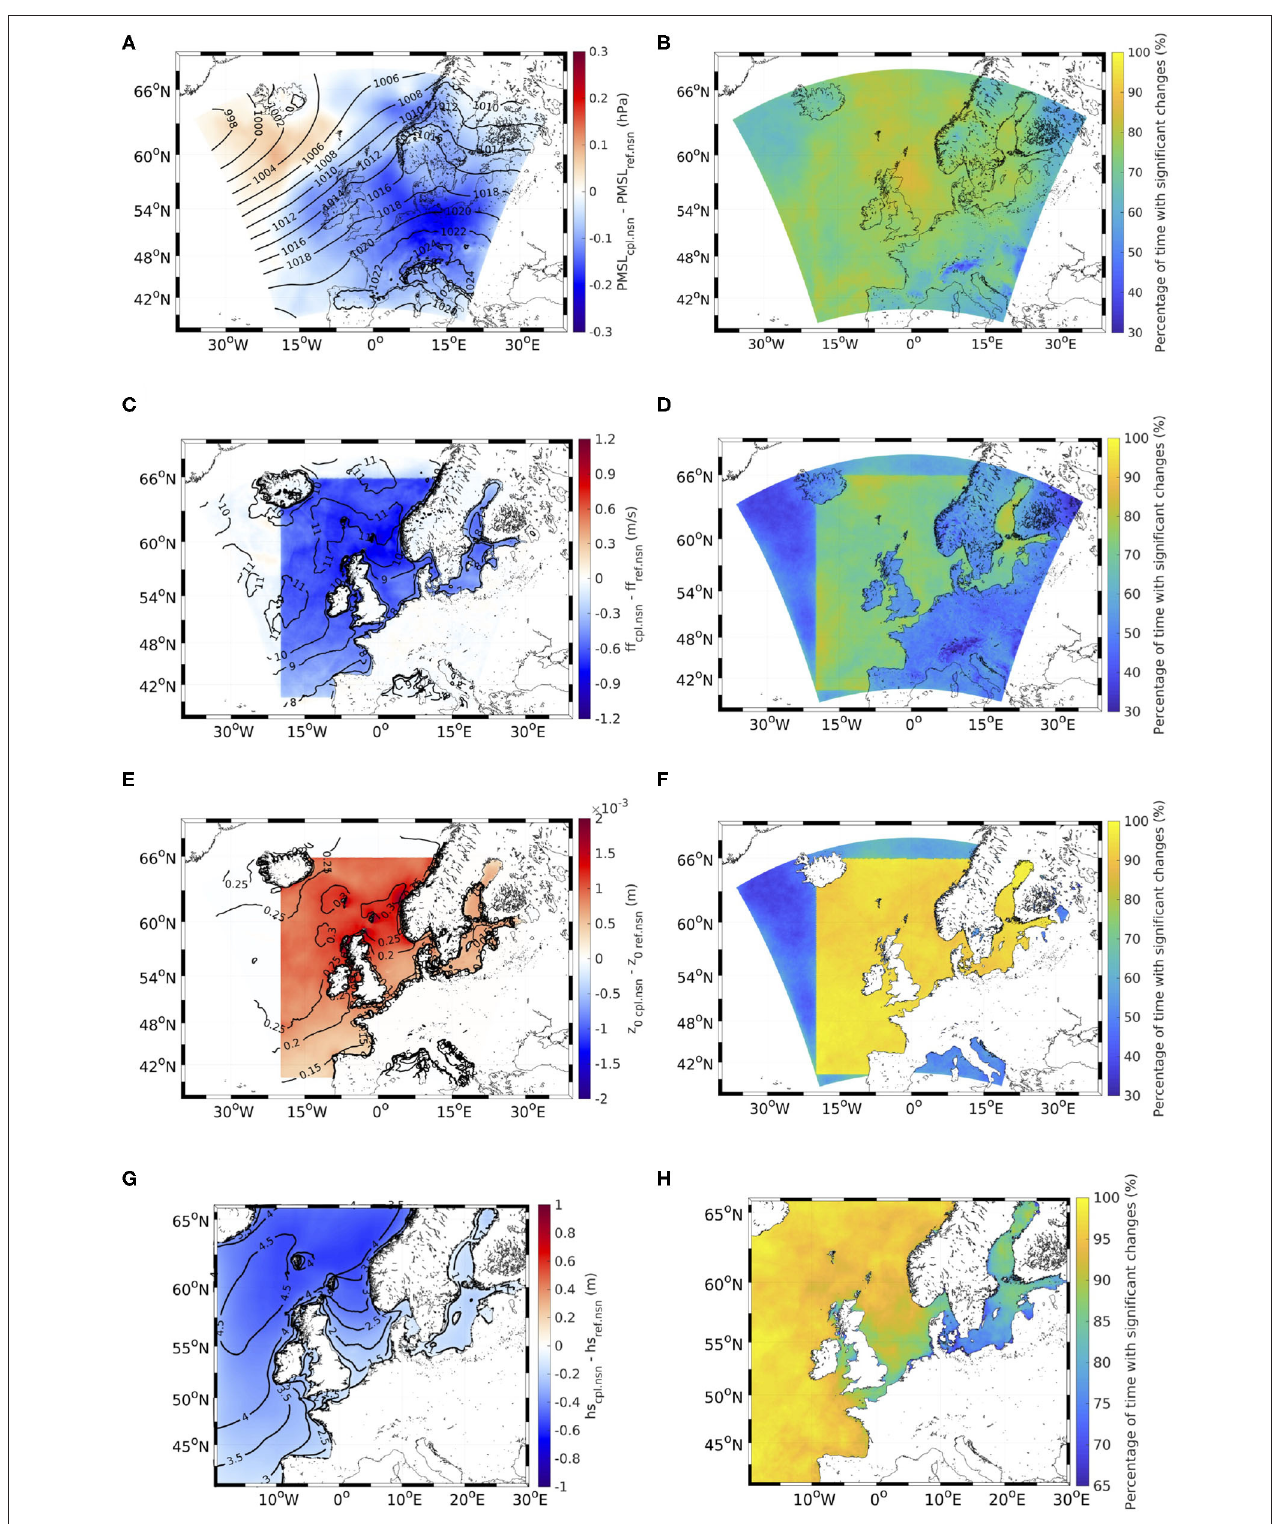
FIGURE 2 | Mean values over 3 months of the MSLP (A) , wind speed (C) , roughness length (E) , and significant wave height (G) . The contours reflect the values of the reference simulation, while the colors represent the difference between the coupled (cpl.nsn) and reference (ref.nsn) ensembles for the ensembles without spectral nudging. The percentage of time with significant differences between the coupled and reference ensembles in the MSLP (B) , wind speed (D) , roughness length (F) , and significant wave height (H) are also shown [Note the different color bar range for (H) ].